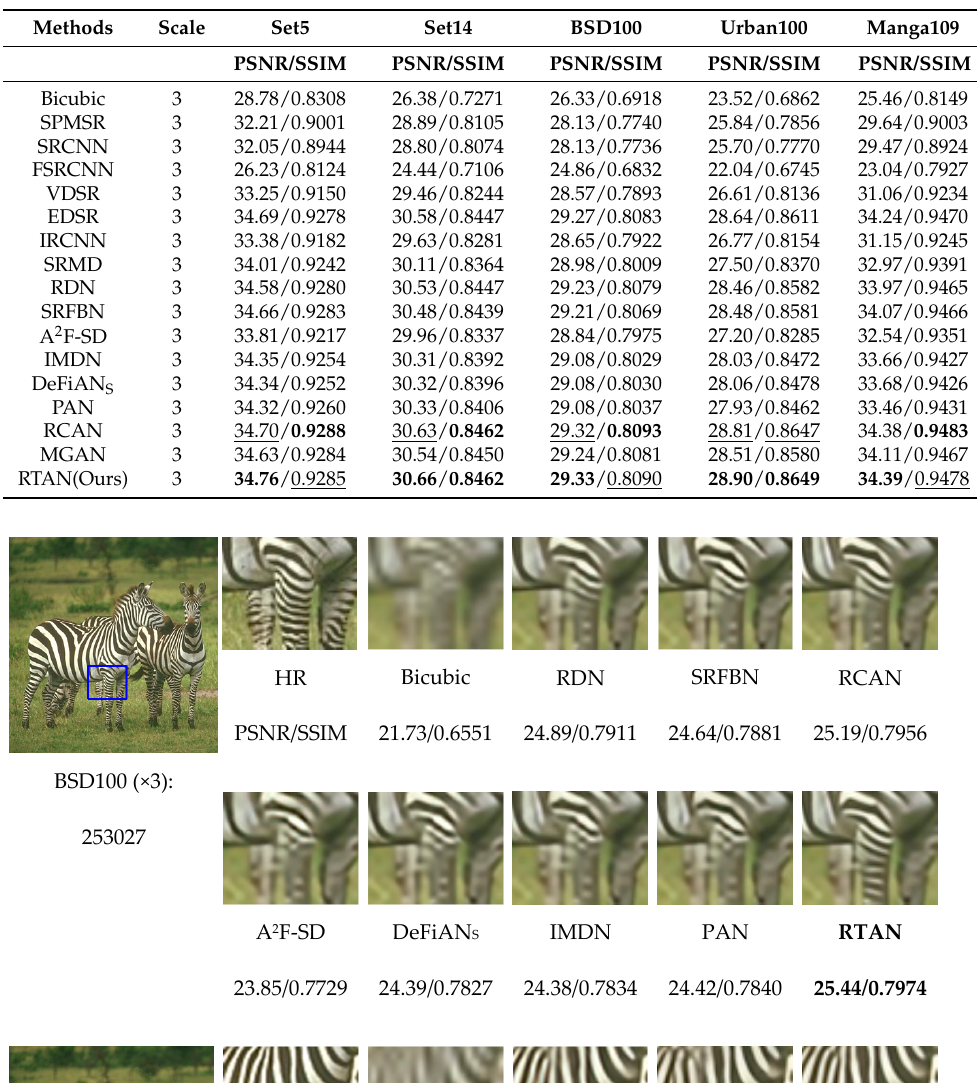
Table 4. The quantitative comparison (i.e., average PSNR/SSIM) with BD degradation model on datasets Set5, Set14, BSD100, Urban100, and Manga109. The best and second-best results are highlighted and underlined, respectively.